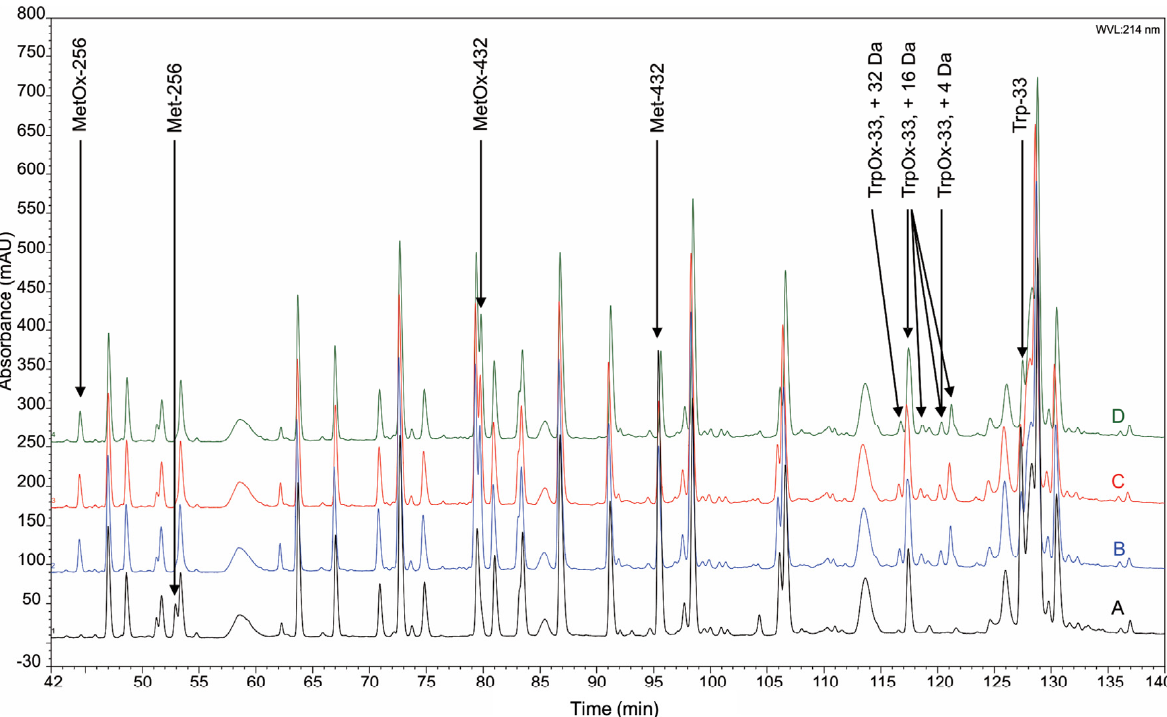
Figure 4. Expanded view of tryptic maps of collected SEC fractions of mAb1. Chromatogram A: control sample (no AAPH stressed mAb1); chromatogram B: collected monomer fraction from SEC; chromatogram C: collected dimer fraction from SEC; chromatogram D: collected higher-order aggregate fraction from SEC. Oxidized Met and Trp products and their parent peaks are labeled in the